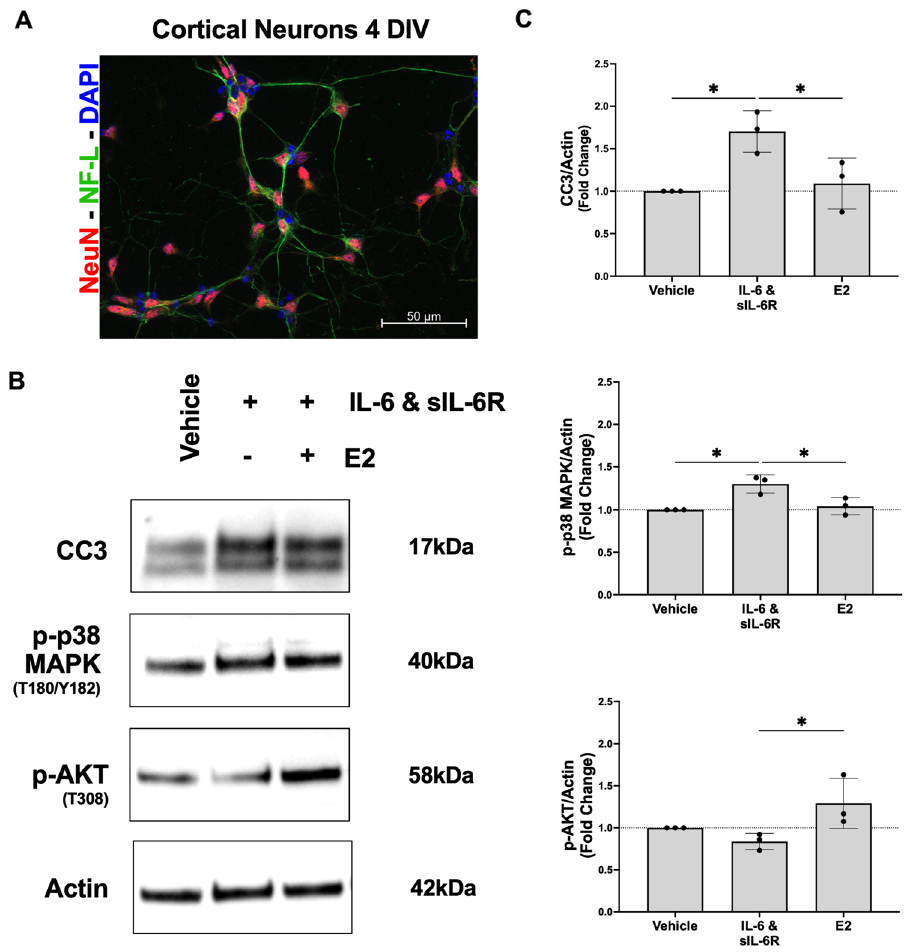
Figure 6. 17β-estradiol (E2) reverses UTI-mediated neuronal changes. ( A ) Representative staining of primary rat cortical neurons 4 days in vitro (DIV) showing expression of two neuron-specific markers, neuronal nuclear protein (NeuN, red) and neurofilament-light chain (NF-L, green). ( B ) At 7 DIV, cortical neurons were treated for 1 h with either vehicle (growth medium), a combination of IL-6/sIL-6R, or combination of IL-6/ sIL-6R plus E2. Representative western blot images of relevant signaling molecules that contribute to apoptosis, neurogenesis, and synaptic activity. Full unedited gel images are provided in supplementary information (Fig. S6). ( C ) Summary plot for fold changes relative to vehicle are presented for the indicated signaling molecules. Neurons treated with IL-6/sIL-6R had statistically significantly more cleaved caspase-3 (CC3) and p-p38 MAP kinase (MAPK) compared to the vehicle and those treated with combination of IL-6/sIL-6R plus E2 (n = 3). There was no significant difference in CC3 or p-p38 MAPK levels between the vehicle and neurons treated with IL-6/sIL-6R plus E2 (n = 3). Neurons treated with treated with combination of IL-6/sIL-6R plus E2 had significantly more p-AKT than the vehicle or those treated with only IL-6/sIL-6R (n = 3). IL-6 was always administered with sIL-6R since neurons do not express the IL-6 receptor. As an additional control we quantified CC3 in the presence of IL-6 alone and found no difference compared to vehicle (Fig. S8). Data are expressed as mean ± SD. *p <